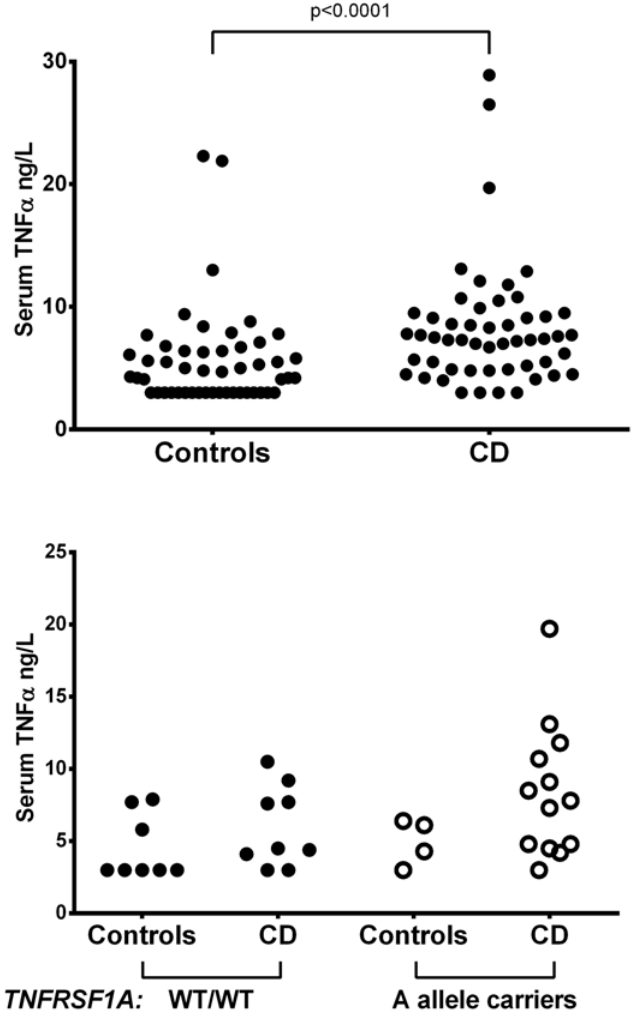
Fig 2. TNFRSF1A polymorphism affects serum TNF- α levels. Serum TNF- α in controls and CD patients (upper panel) and in patients subdivided according to the TNFRSF1A c.625+10A > G (rs1800693) polymorphism (lower